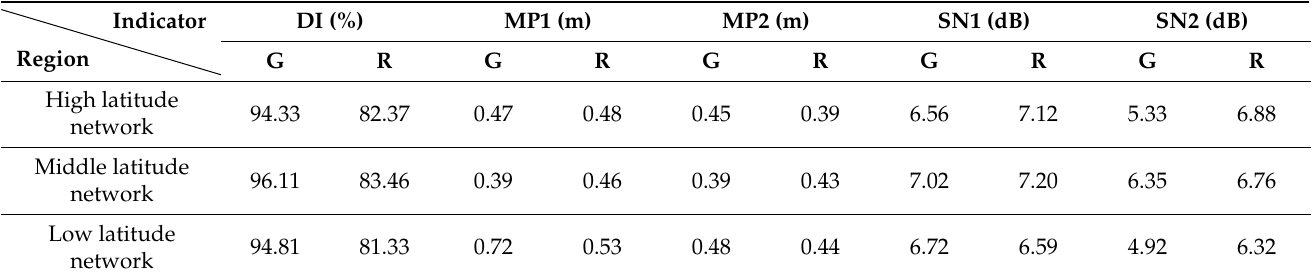
Figure 3. The results of the data quality check. Table 5. The mean value of each data quality indicator in the three networks.